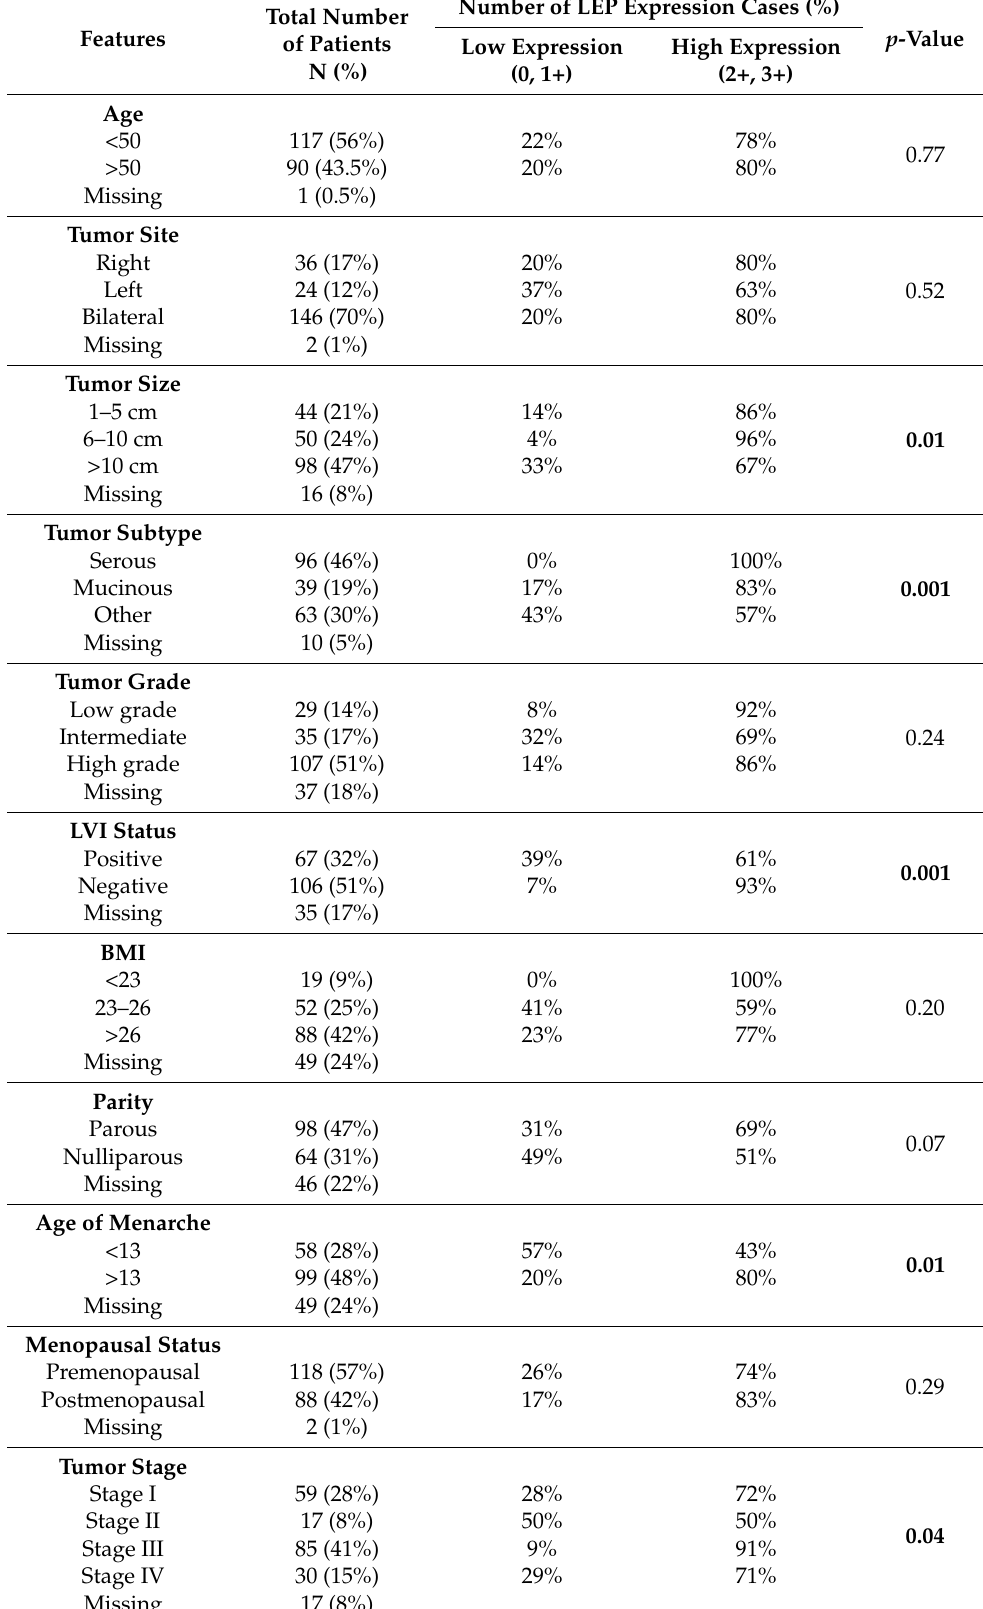
Table 1. Baseline characteristics (clinicopathological features) of our OC patient cohort, and their correlation with LEP protein